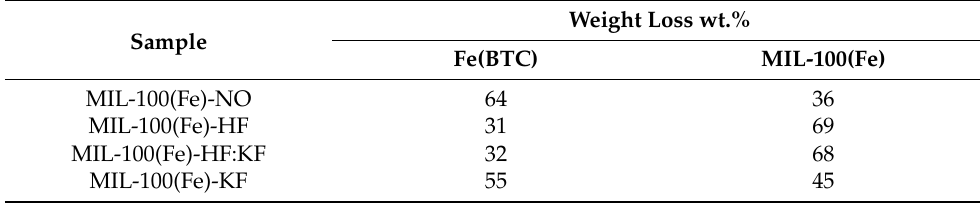
Table 2. Ratio of the different phases calculated by